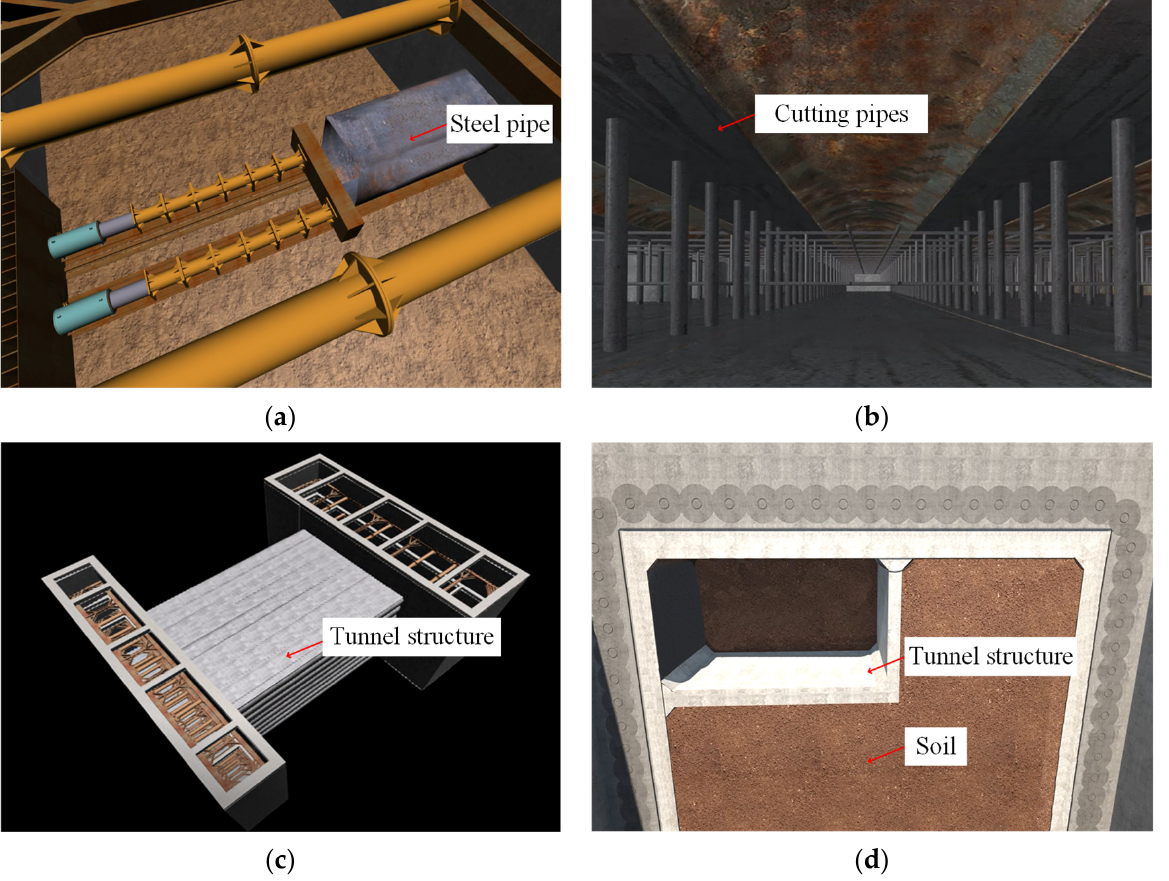
Figure 1. Schematic of pipe roof structural method: ( a ) pipe jacking; ( b ) cutting and welding of pipes; ( c ) pouring of concrete; ( d ) large-scale excavation.